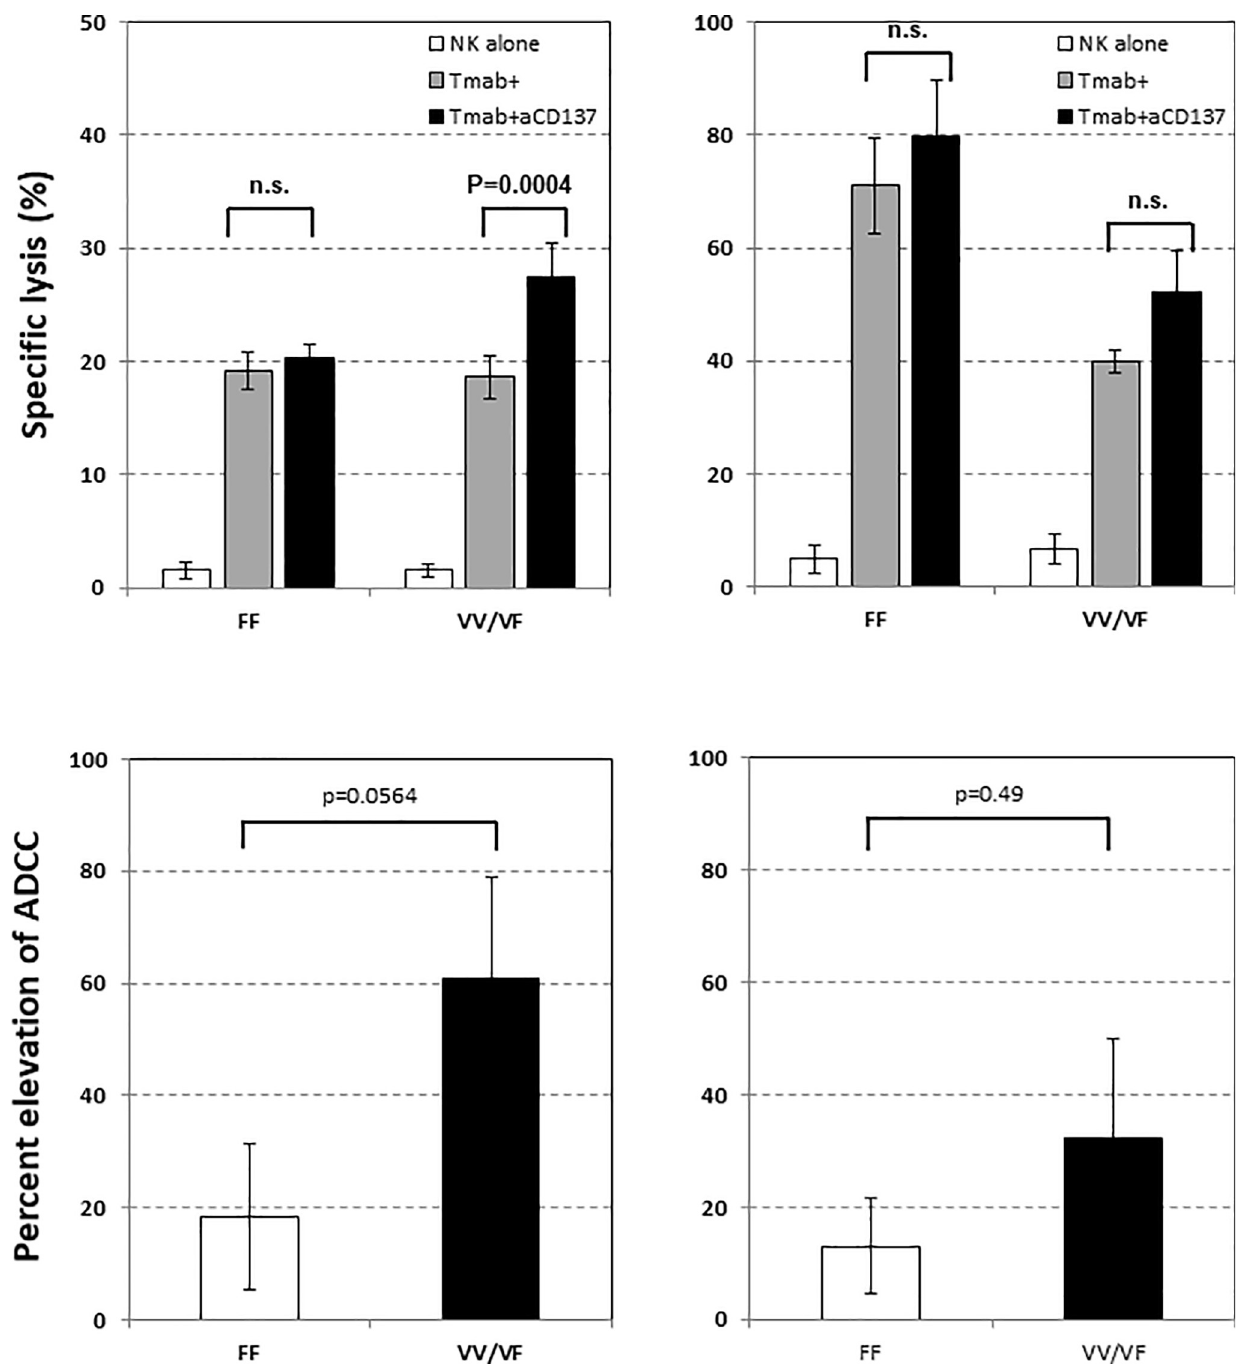
Fig 6. Effects of α CD137 addition to Tmab on the ADCC against Panc-1 (6A, left panel) and Capan-1 (6A, right panel) were compared between VV/ VF and FF individuals. The percentage of increase in ADCC after the addition of anti-CD137 mAb against Panc-1 (6B, left panel) and Capan-1 (6B, right panel) in each individual were calculated as